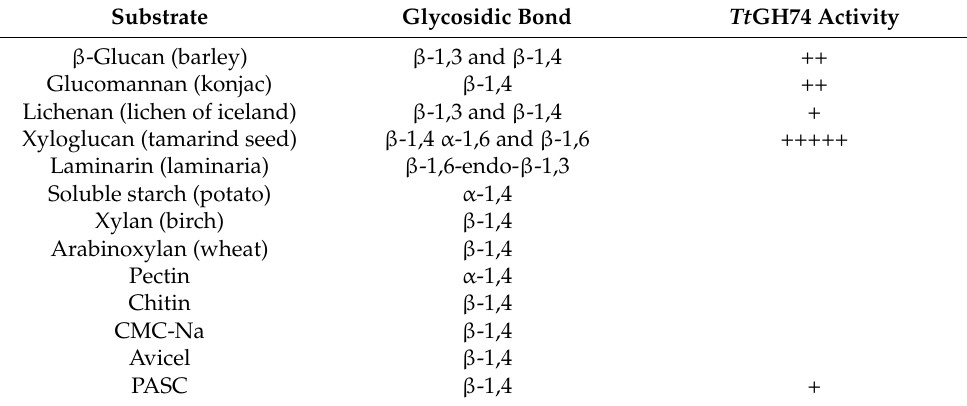
Table 1. The substrate specificity of Tt